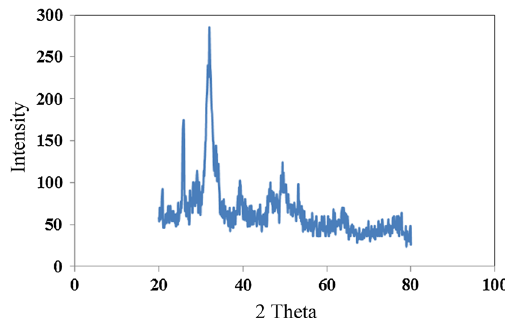
Fig. 15 XRD pattern of CEM facing cathode